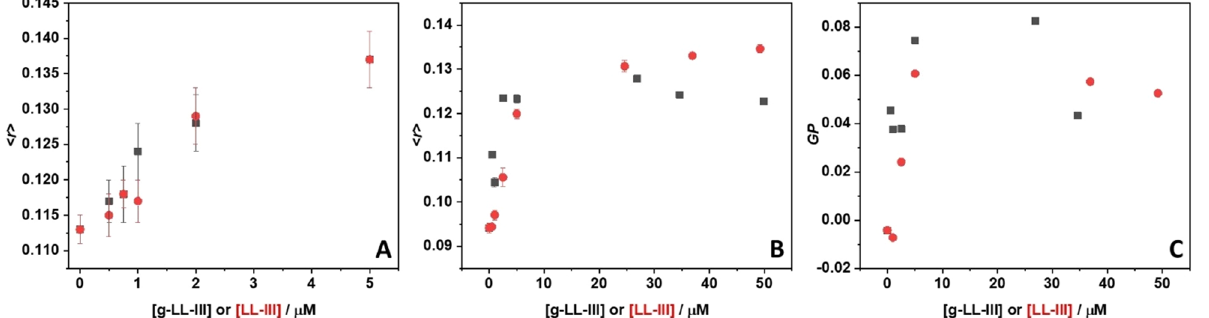
Figure 3. Fluorescence anisotropy (< r >) of the probes ( A ) DPH, ( B ) Laurdan and ( C ) generalized polarization ( GP ) of Laurdan embedded in POPC/POPG vesicles in the presence of g-LL-III (black squares) and LL-III (red circles). All the experiments were performed at 25 °C in 10 mM phosphate buffer, pH